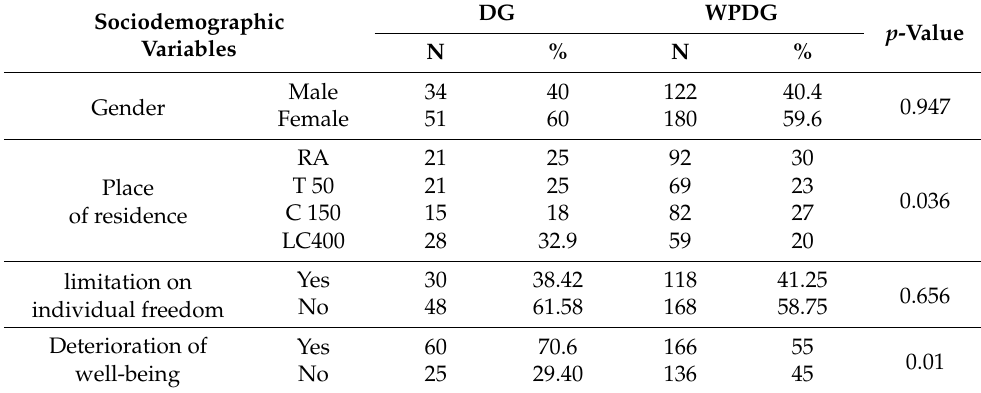
Table 1. Sociodemographic characteristics of the respondents.